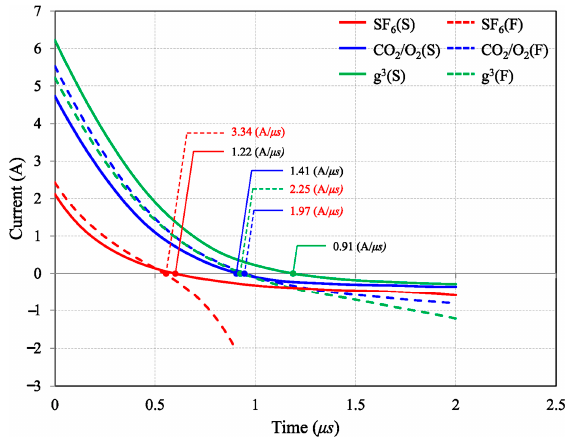
Figure 6. Comparison of interrupting current behaviors according to interrupting success and failure of SF 6 , CO 2 /O 2 , and g 3